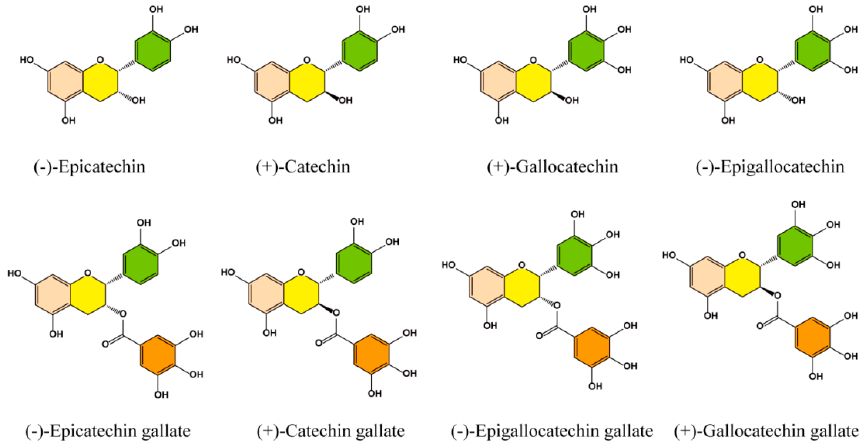
Figure 1. Chemical structure of the main catechin components in green tea polyphenols.